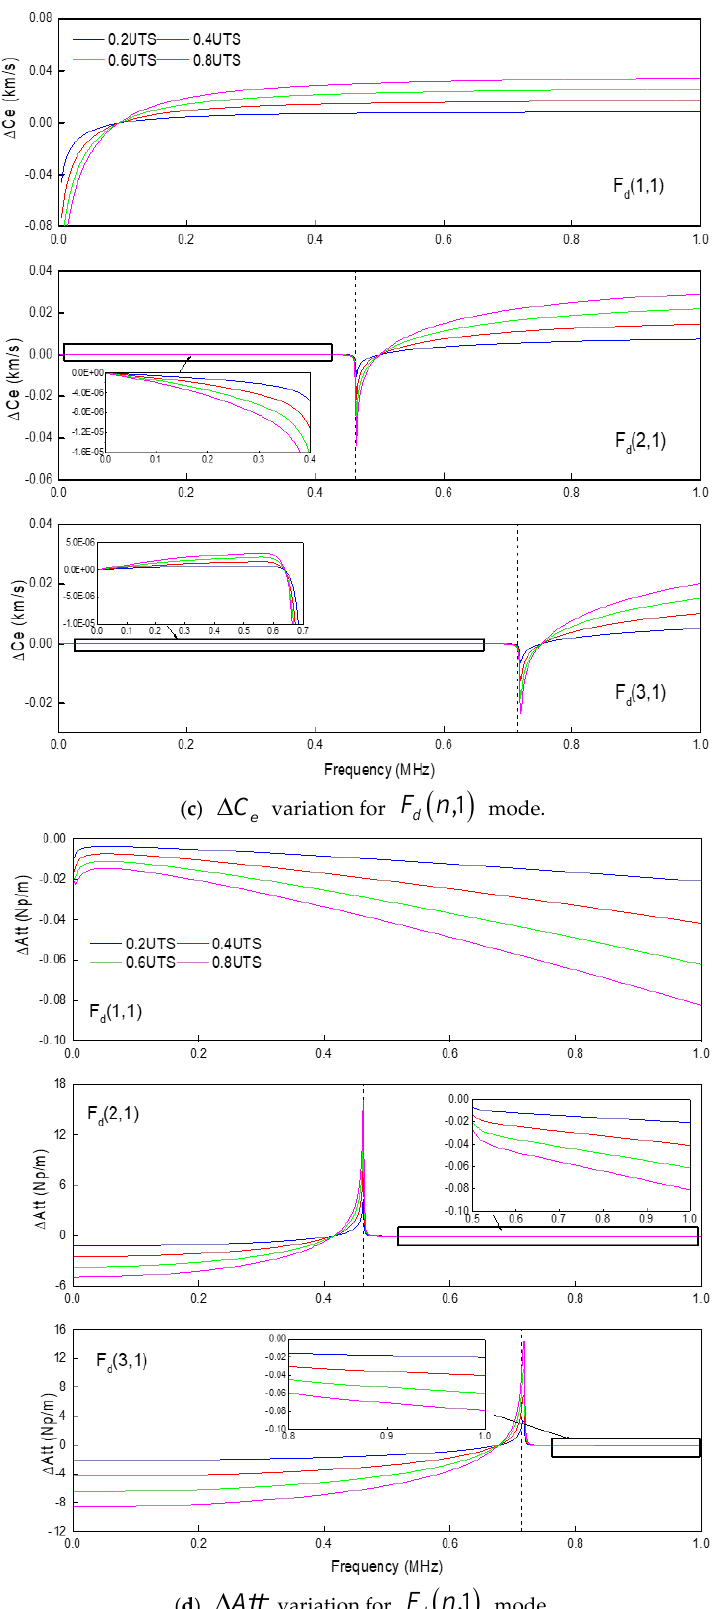
Figure 16. Influence of initial tensile stress on energy velocity and attenuation: ( a ) ∆ C e variation for the L d ( 0, m ) mode; ( b ) ∆ Att variation for L d ( 0, m ) mode; ( c ) ∆ C e variation for F d ( n ,1 ) mode; ( d ) ∆ Att variation for F d ( n ,1 )